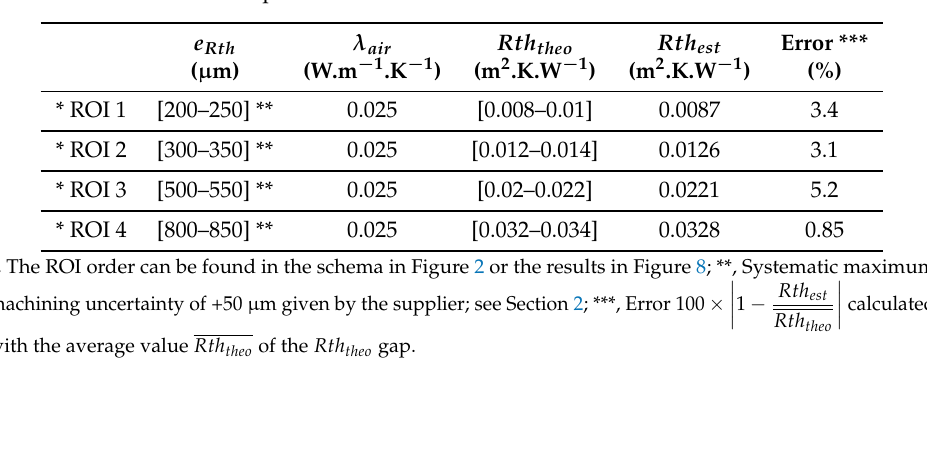
Figure 8. Fields of: ( a ) estimated amplitude and ( b ), calculated thermal resistance based on the calibration curve in Figure 5a. Table 1. Comparison between the theoretical and estimated